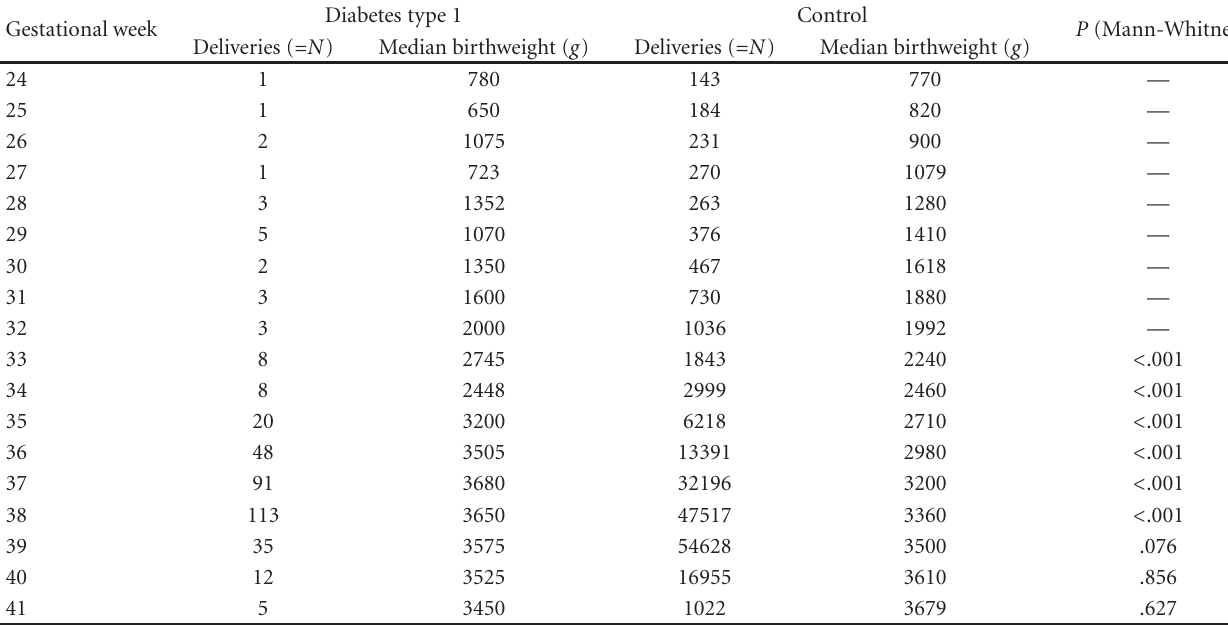
Table 3: Birth weight per gestational